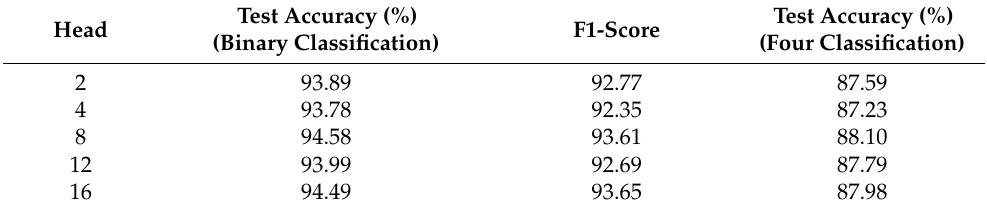
Table 4. Comparison of ablation experiments with different Head.